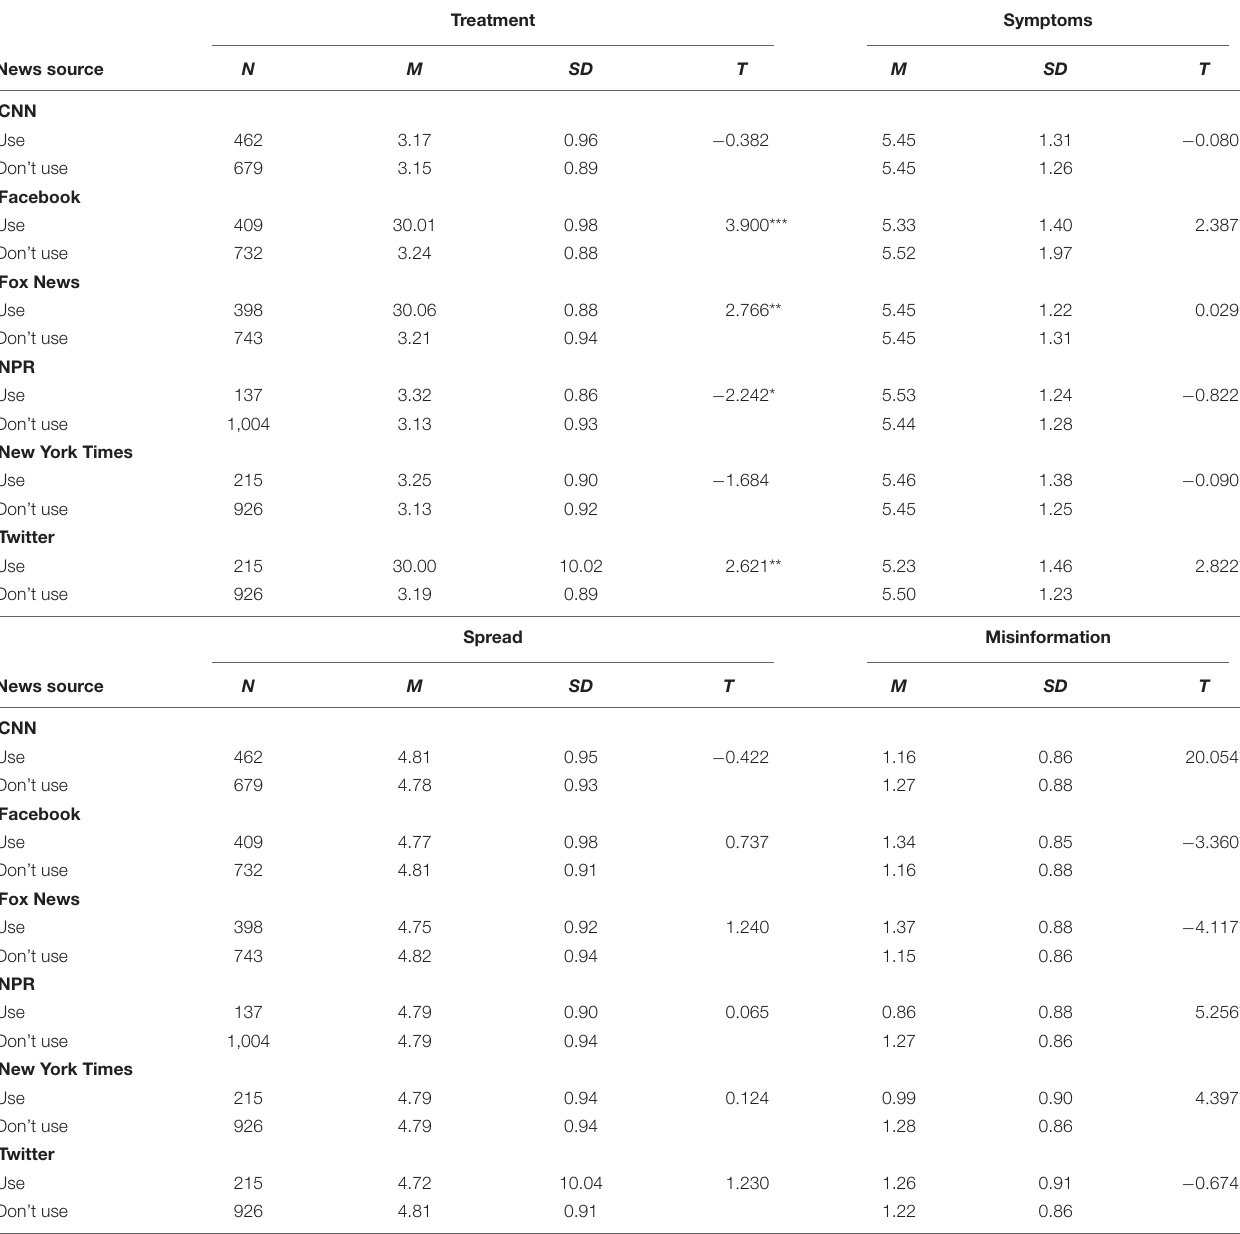
TABLE 4 | T -tests comparing knowledge scores for people who use and do not use specific news sources. Treatment